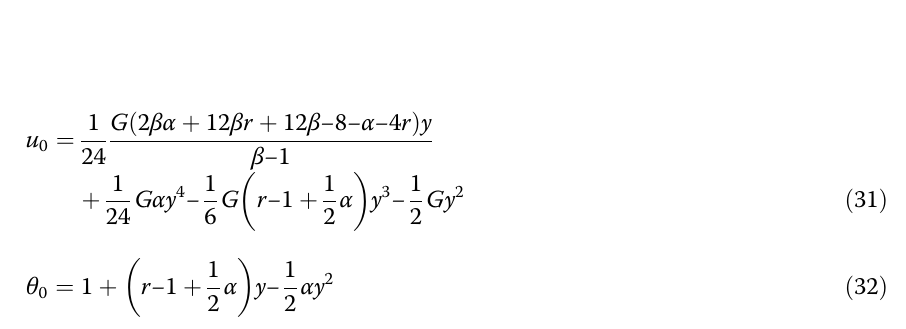
Fig. 11 First-order velocity (u[1] profile, r = − 1, ϵ = 0.25, P = 0.71, and β = 0)